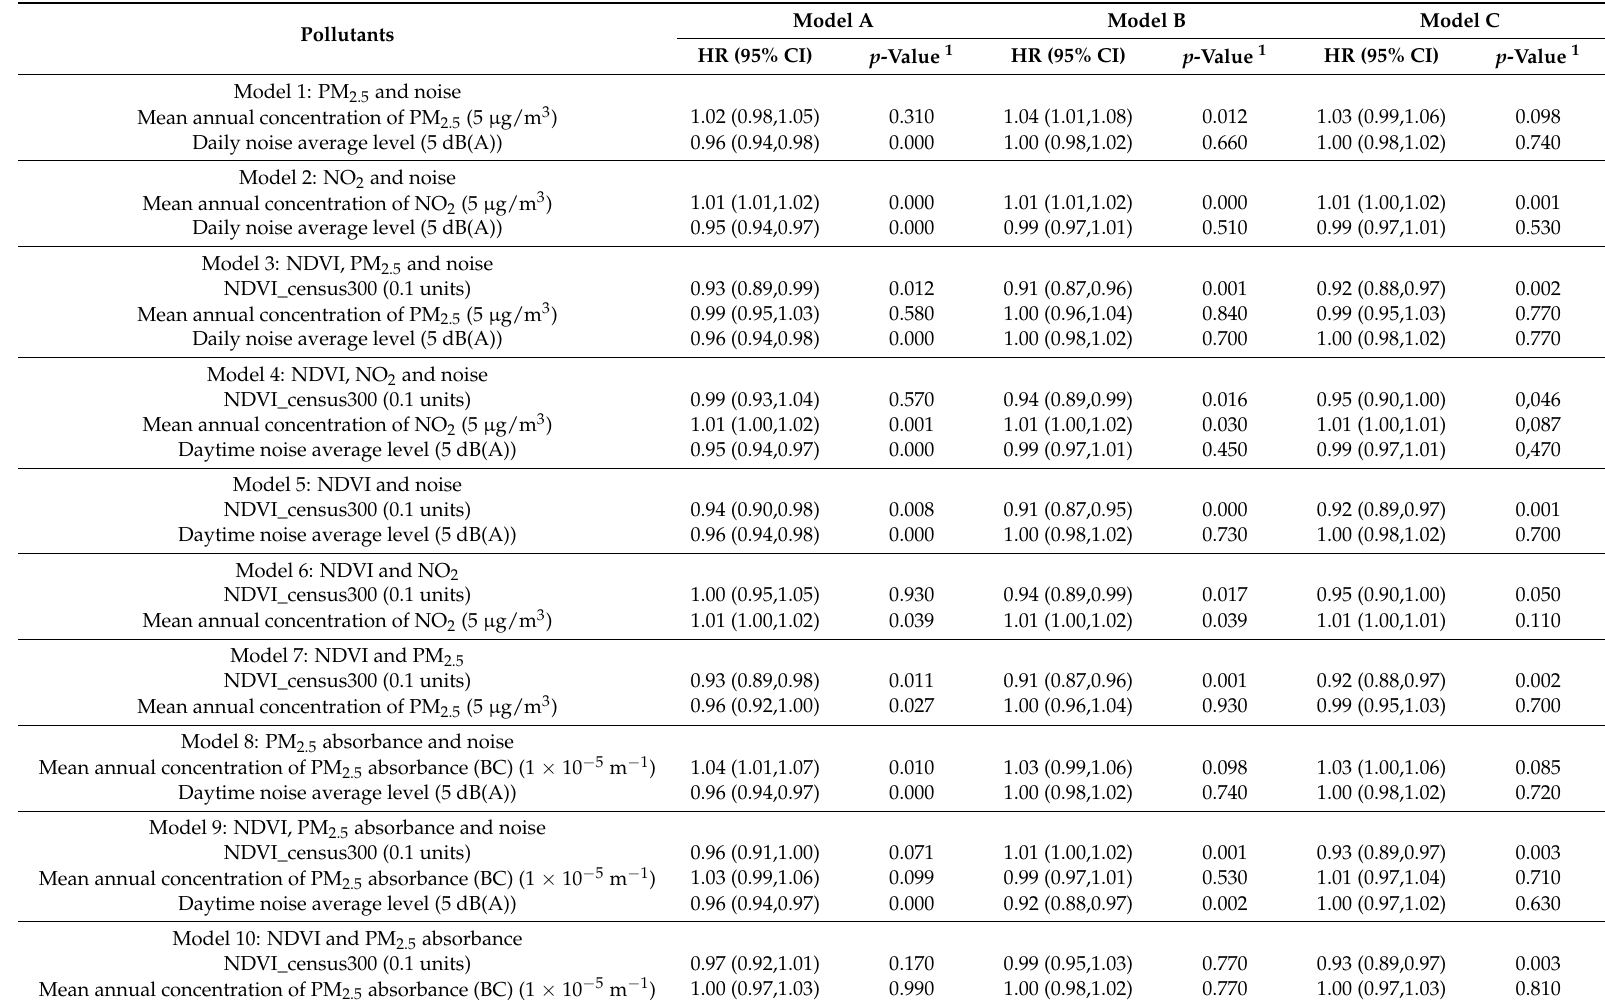
Table 6. Multiple pollutant models ( n = 792,649).